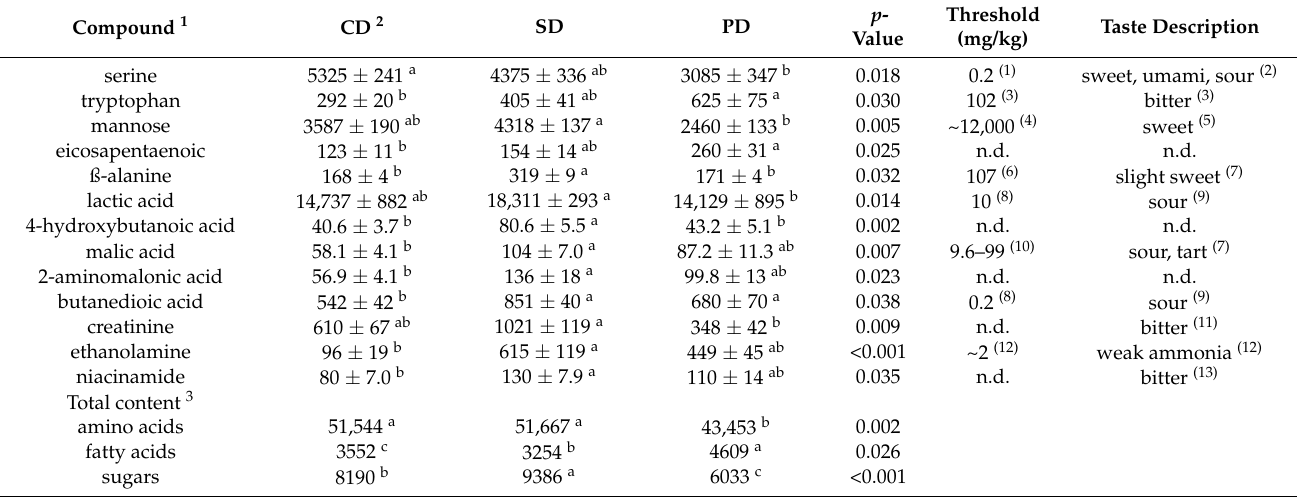
Table 6. Differences in metabolites ( p < 0.05) between dry-cured leg produced from lamb fed three finishing diets. Results are presented as mean ± STD ( n = 8).